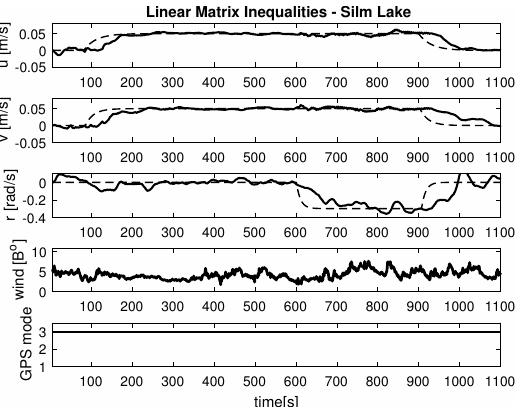
Figure 15. Ahead maneuver with longitudinal velocity u = 0.1 [m/s], v = 0.05 [m/s], r = − 0.3 [rad/s], wind [ B o ] and GPS mode [-], maneuver duration 1100 [s].